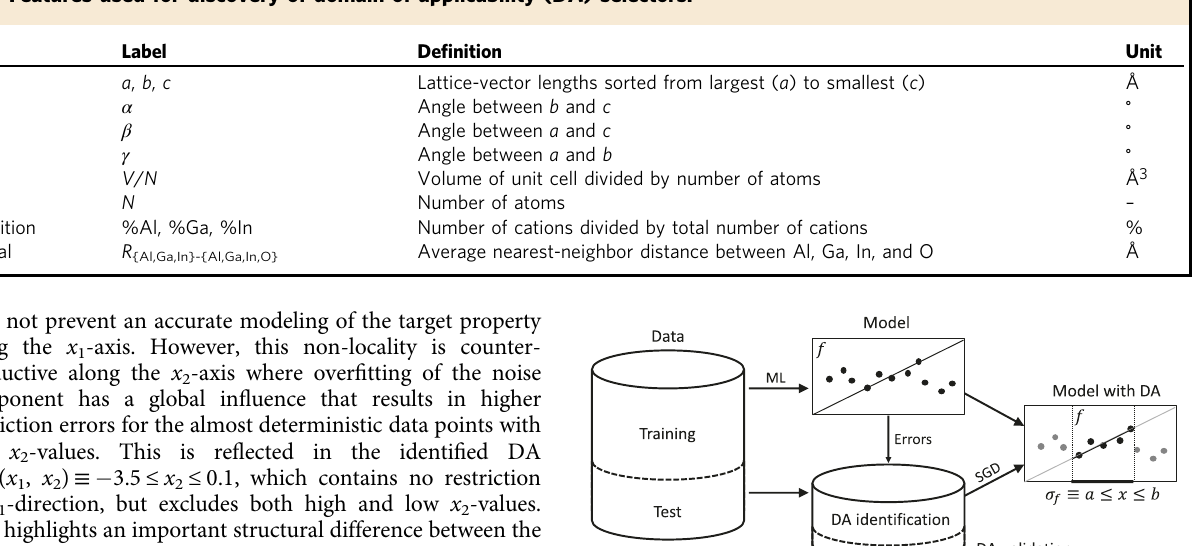
Table 1 Features used for discovery of domain of applicability (DA) selectors.